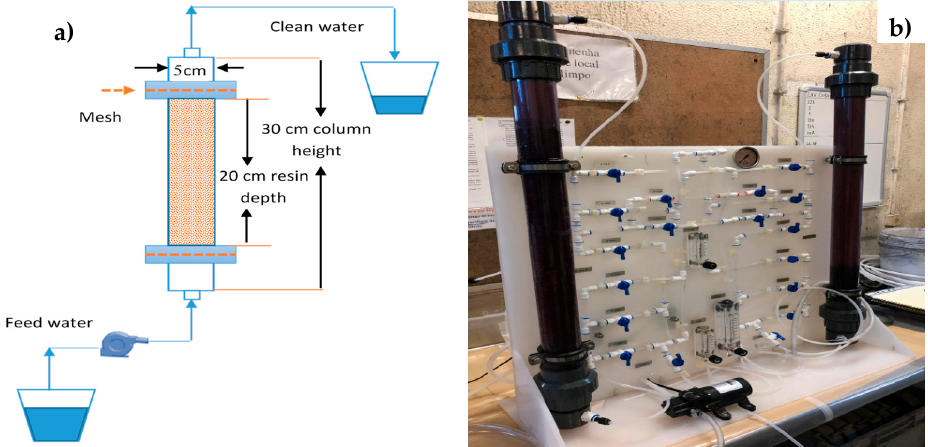
Figure 1. The column systems used in the ( a ) small laboratory-scale and ( b ) large-scale experiments used in the plant.